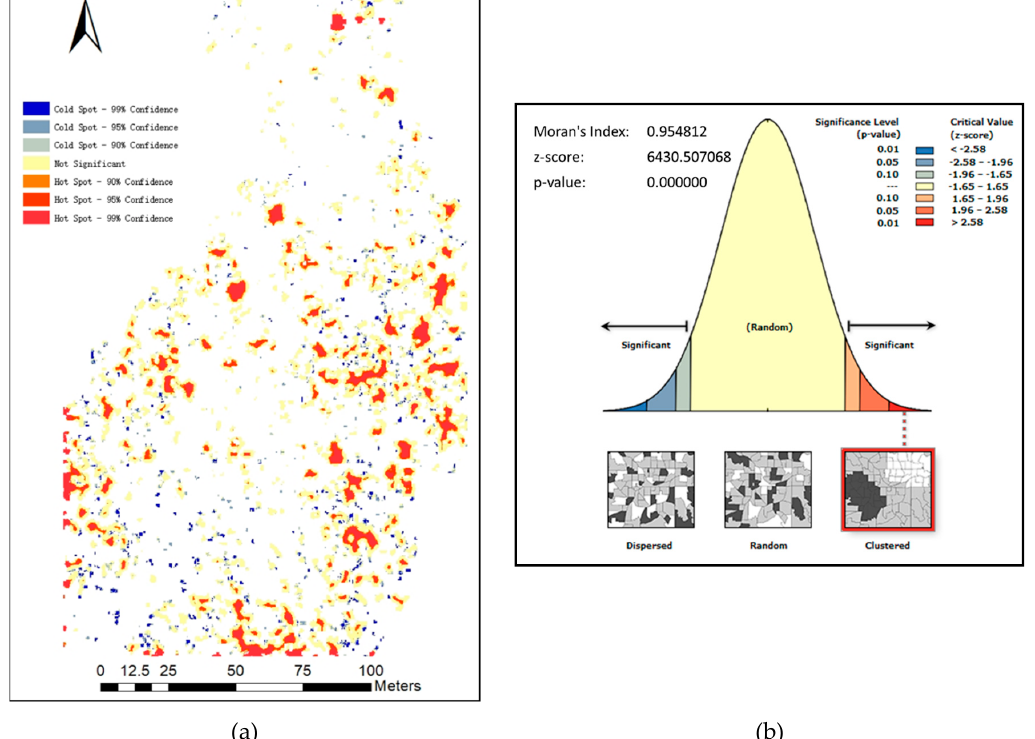
Figure 3. The results of the spatial statistics analysis: ( a ) Optimized hotspot analysis, ( b ) spatial autocorrelation analysis after ArcGIS analysis.